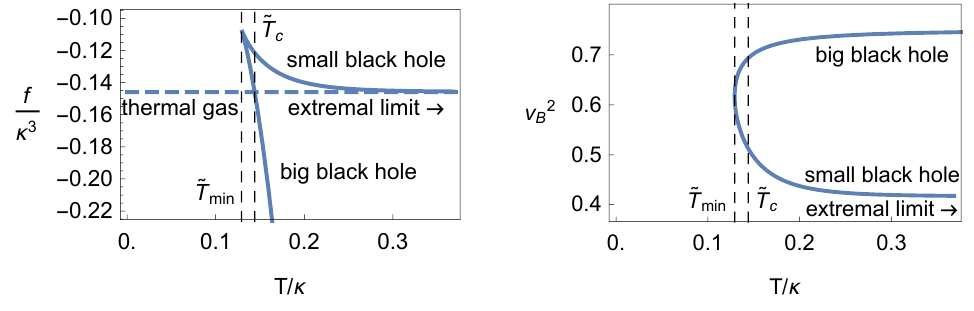
Figure 3 . Dimensionless free energy density f=(cid:20) 2 and butter(cid:13)y velocity v 2 sionless temperature T=(cid:20) for gapped phase with d = 2 ; (cid:18) = 8. In the left plot, black hole solutions are represented by solid line, thermal gas solution are represented by dashed